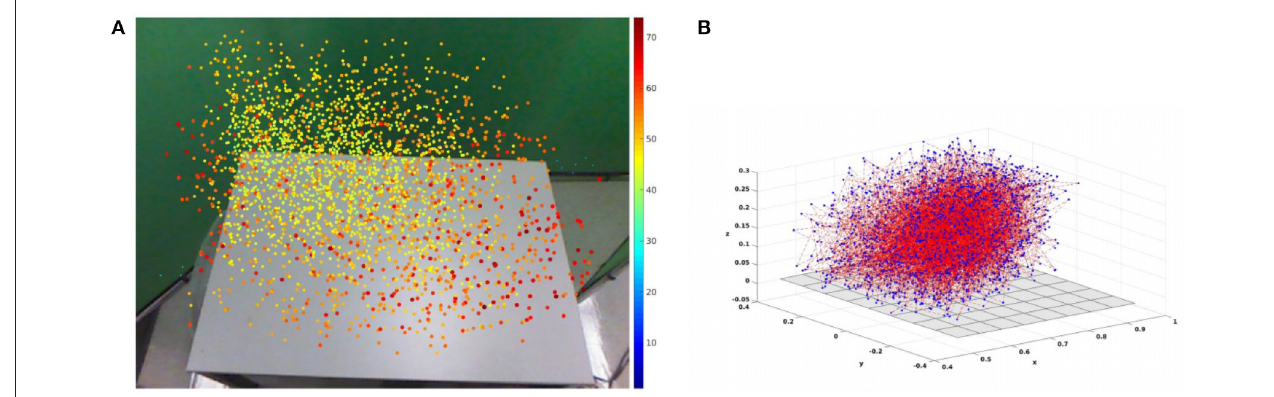
FIGURE 3 | Two visualizations of the Peripersonal Space (PPS) Graph P , with size N = 3,000. Each visualization shows wide coverage that facilitates movement throughout the environment, with a few sparse patches. (A) An example RGB percept of the empty environment, overlayed with the ( u , v ) center of mass locations for all N nodes. The dot for each node is colored and sized according to its mean disparity value d (see key along right edge). Nodes with higher disparity (closer to the camera) appear larger and more red, while nodes with lower disparity (farther from the camera) appear smaller and closer to blue. (B) The nodes of P displayed in the true world ( x , y , z ) coordinates of the Baxter Robot’s default frame of reference. The gray plane represents the surface of the table. Nodes are plotted as blue points. The 2,999 edges in the original chain from motor babbling are shown as dotted red lines. Not shown are the edges added according to the safe motion